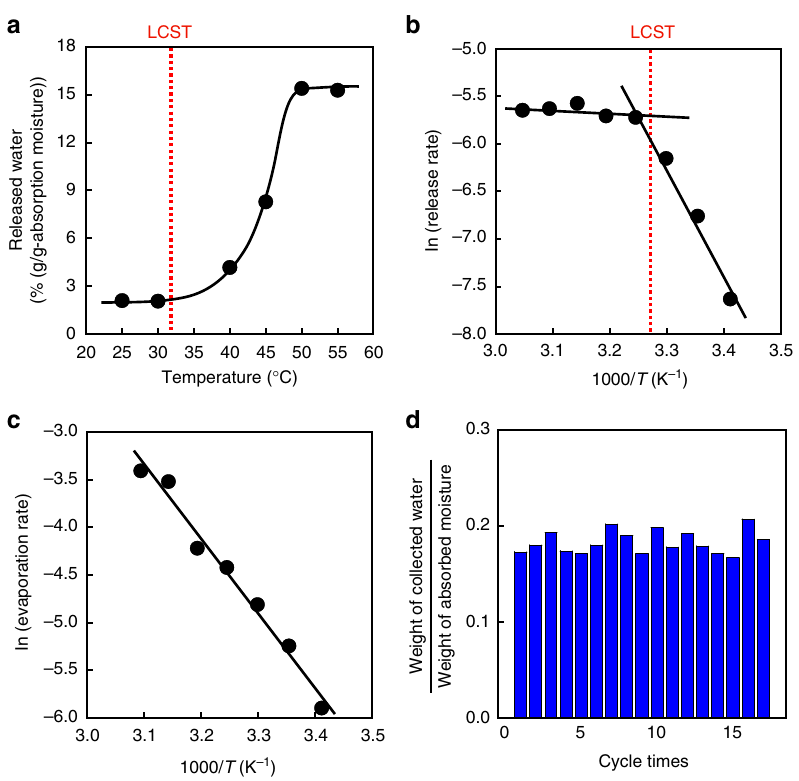
Fig. 4 Thermo-responsive water oozing behaviors of IPN gels. a Relationship between temperature and the amount of water oozed from the PNIPAAm/Alg IPN gel. Plots of the natural logarithm of the rate versus the reciprocal of the absolute temperature for water oozing from ( b ) the dried IPN gels and (c) pure water. d Cycle tests of water oozing from the surface of the IPN gel at 50 °C after the moisture absorption at 27 °C and 80%